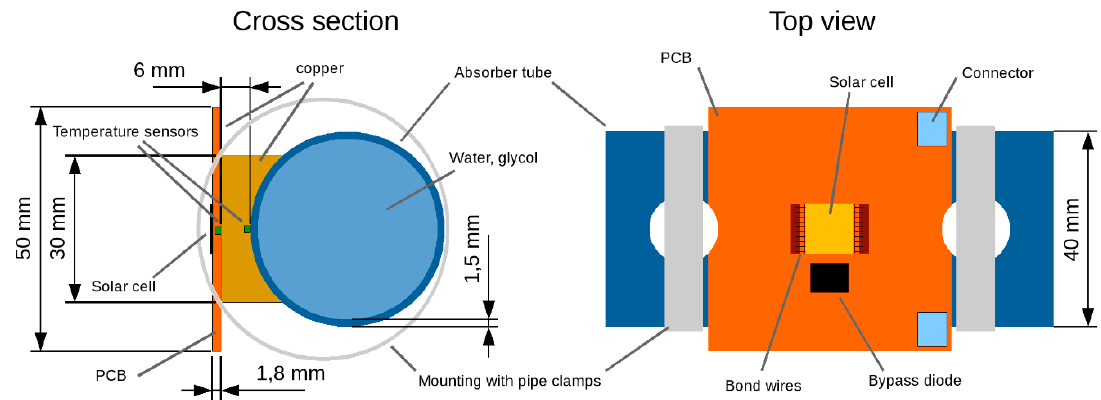
Figure 15. Schematic representation of the hybrid absorber test setup. In order to demonstrate the basic functionality, one multi-junction solar cell is used. Left: Cross section of the absorber tube with good heat conduction (copper adapter) to the solar cell PCB. Right: Front view of the hybrid collector.